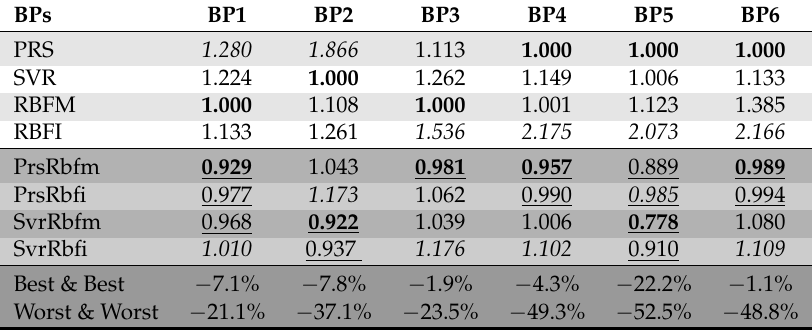
Table 2. Normalized means of RMSE of the metamodels for each benchmark problem with 3 ( k + 1 )( k + 2 ) training points.